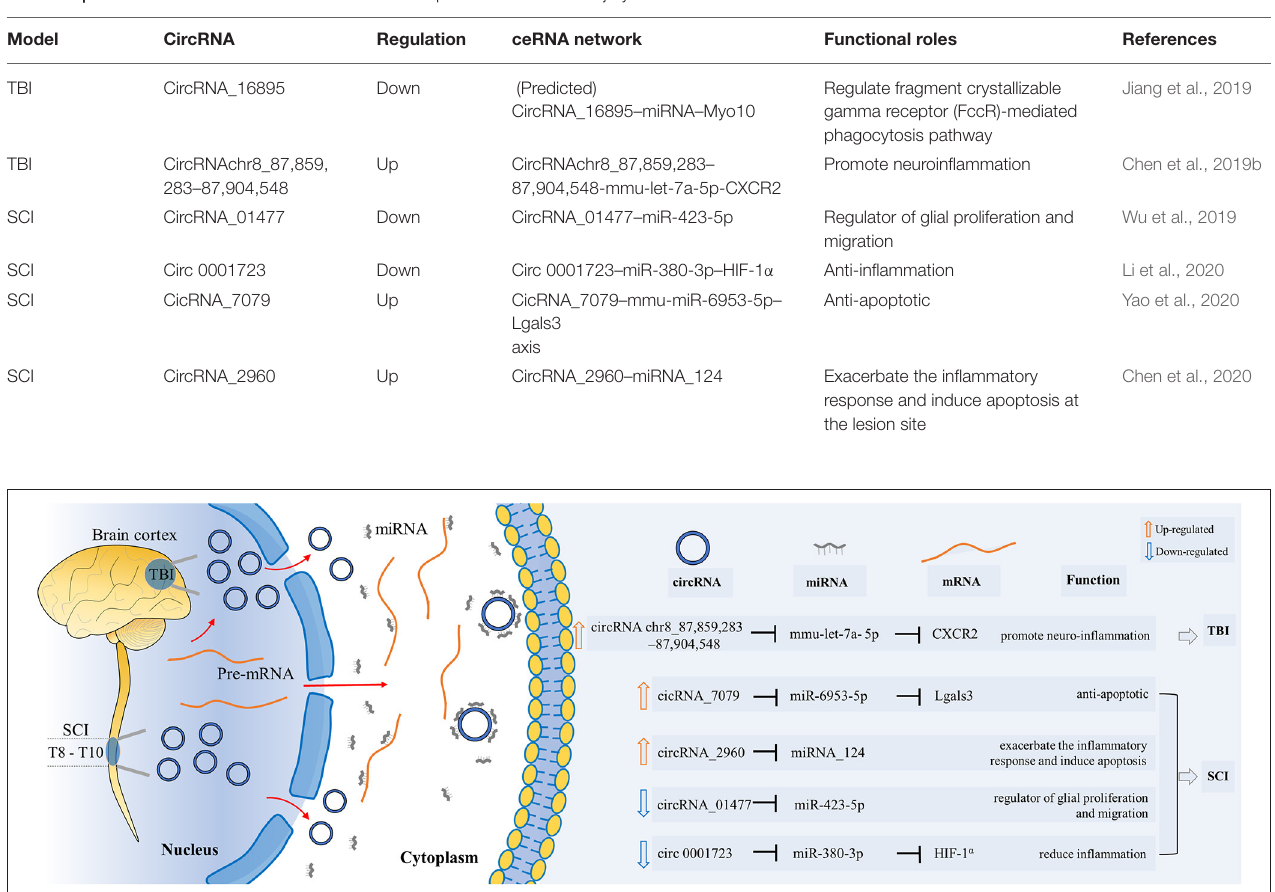
TABLE 2 | Functional characterization of the circRNAs in post-traumatic CNS injury.